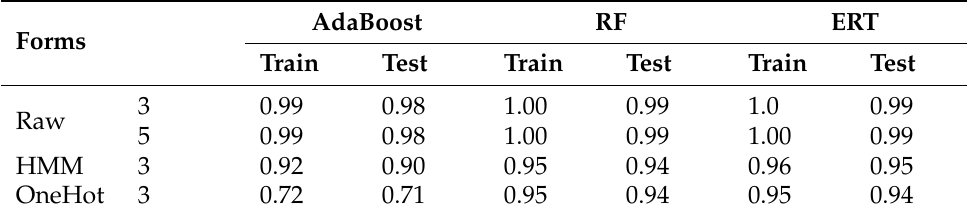
Table 6. The A cc of models for the thrust prediction in different forms of input variables.